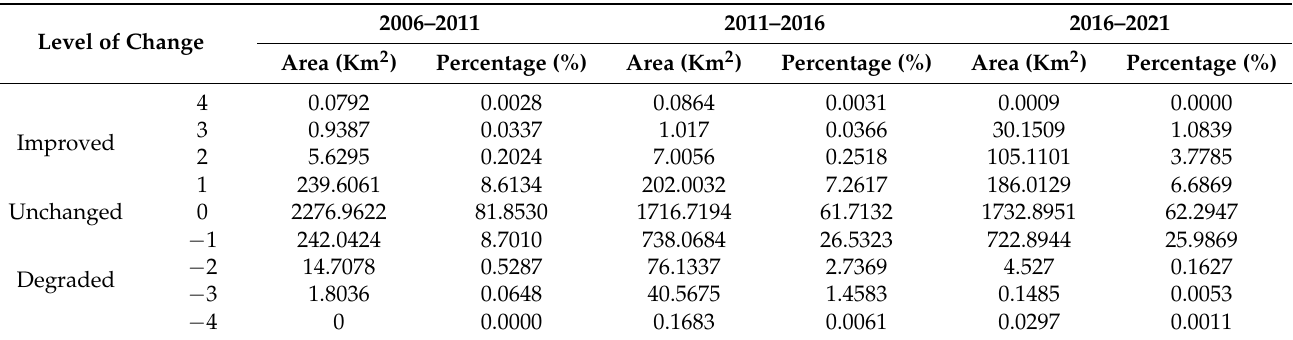
Figure 8. Spatial distribution of RSEI grade changes and statistics of changes in buffer area and nominated area. ( a , c , e ) Spatial distribution of RSEI grade changes, 2006–2011, 2011–2016 and 2016–2021. ( b , d , f ) The proportion of ecological environment. Table 4. Percentage of RSEI grade change statistics, 2006–2011, 2011–2016 and